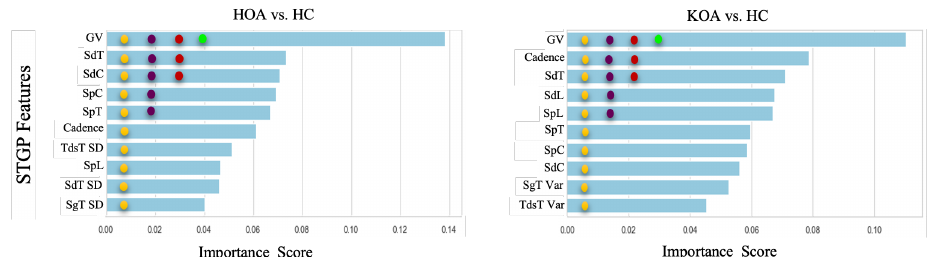
Figure 17. Feature ranking generated by the Random Forest. The filled circles with colors green, red, purple, and yellow indicate the 1 top, 3 top, 5 top, and 10 top features, respectively.